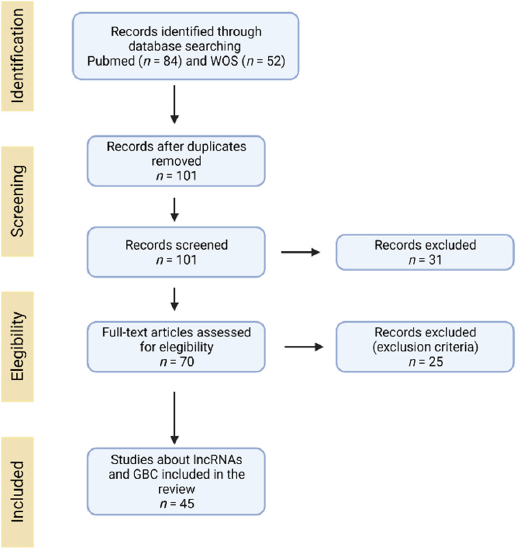
Figure 1. Search diagram used in the systematic review.